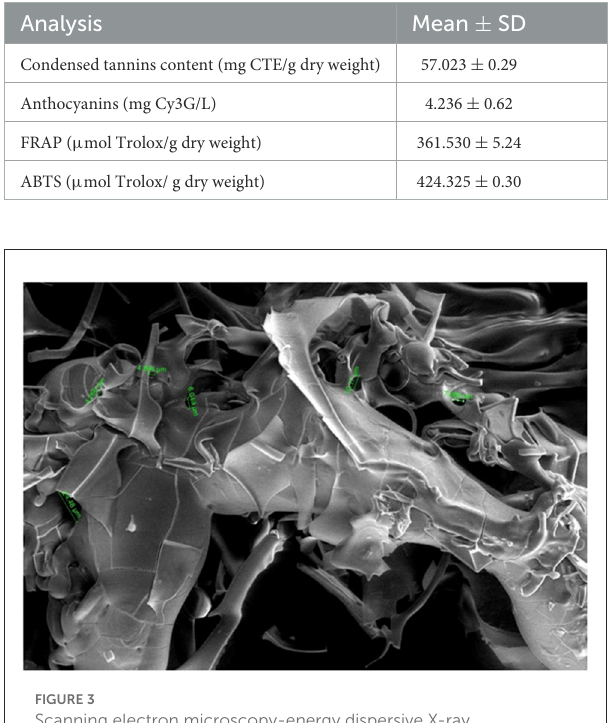
FIGURE3 Scanning electron microscopy-energy dispersive X-ray Spectroscopy (SEM-EDX) image of water-soluble phenolic compounds extracted from Polygonum equisetiforme